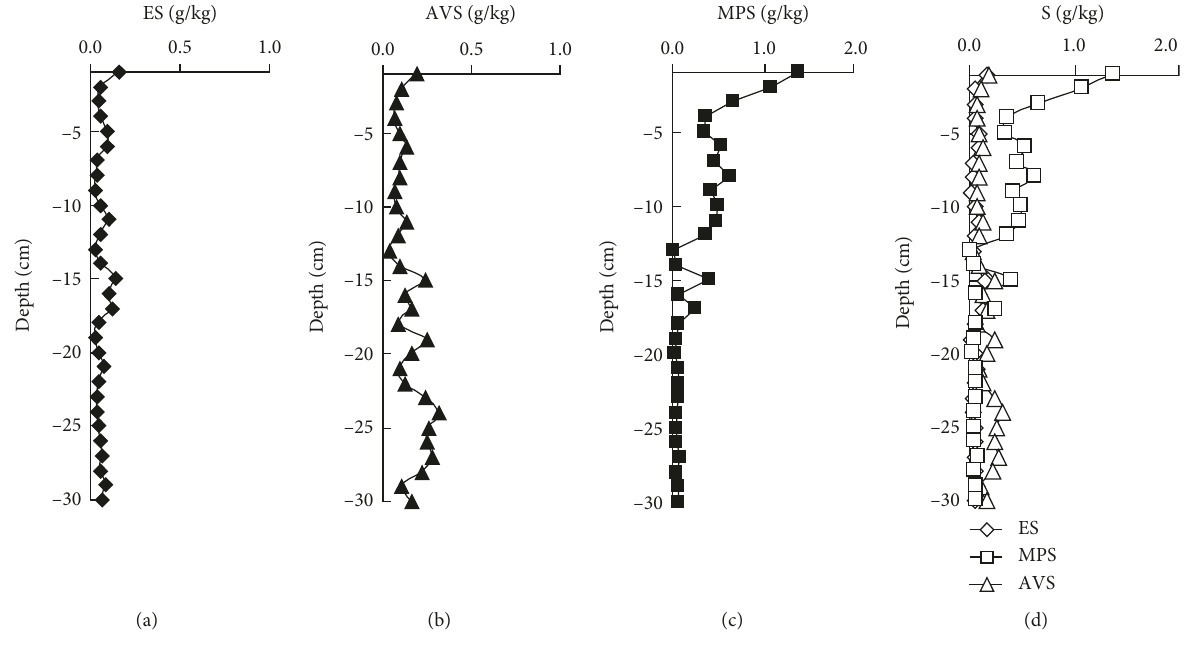
Figure 3: Profiles of ES (a), AVS (b), and MPS (c) in sediments and their comparison (d).